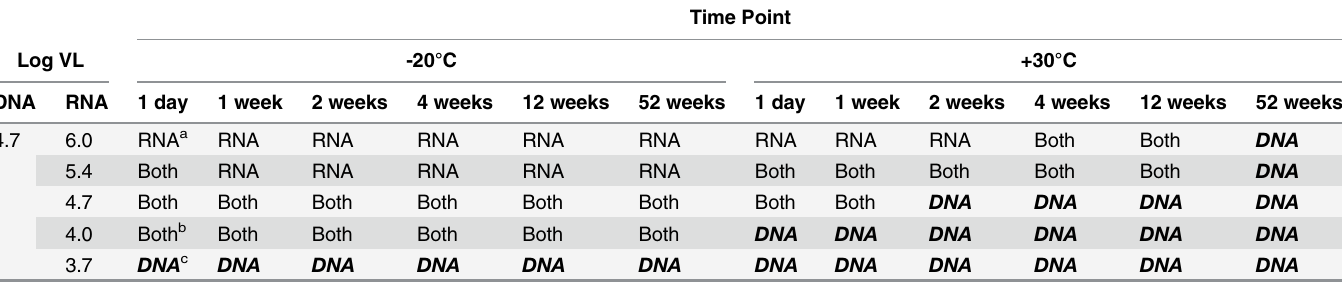
3.7 DNA c DNA DNA DNA DNA DNA DNA DNA DNA DNA DNA DNA a RNA: RNA detected, DNA not detected. b Both: DNA and RNA detected c DNA detected, RNA not detected; Values where RNA was not detected are emphasised in bold